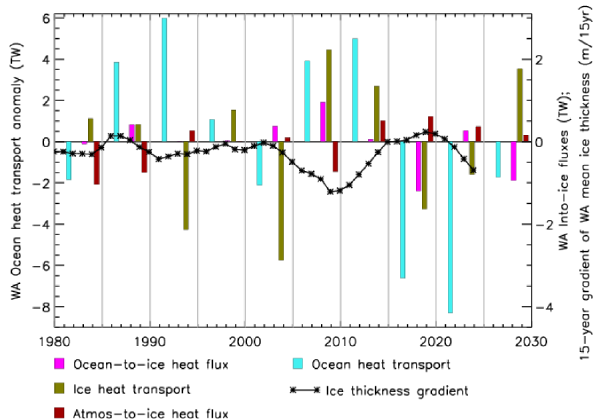
Fig. 7. The heat budget analysis for the western Arctic region, shown for the ANT 1 run, with a time series of the ANT 1 ice thick- ness gradient superimposed. Notice that the ocean heat transport is shown on a smaller scale (left) than that of the into-ice variables (right).